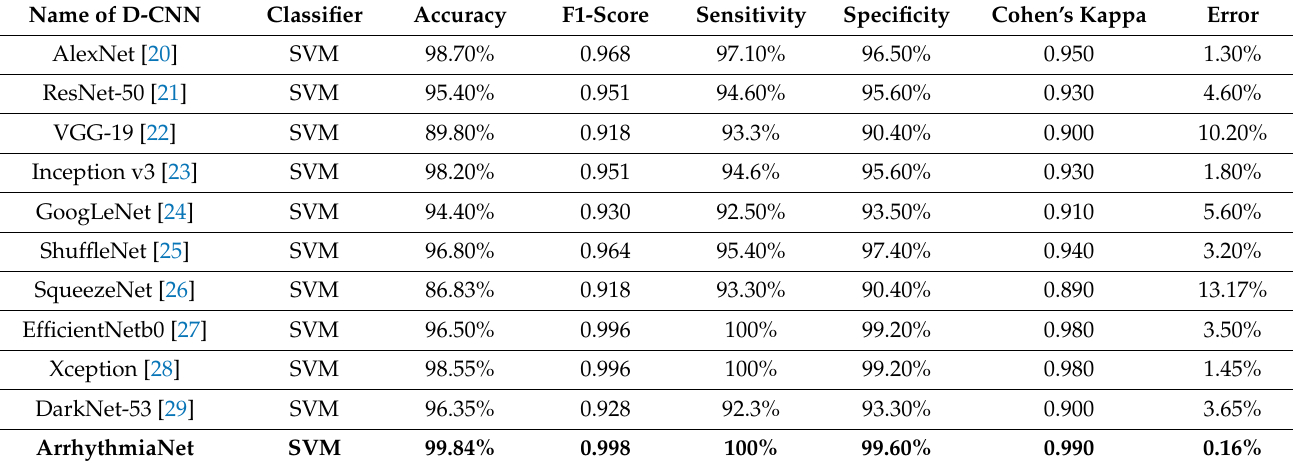
Table 3. Comparison of the testing performance of the different D-CNNs with